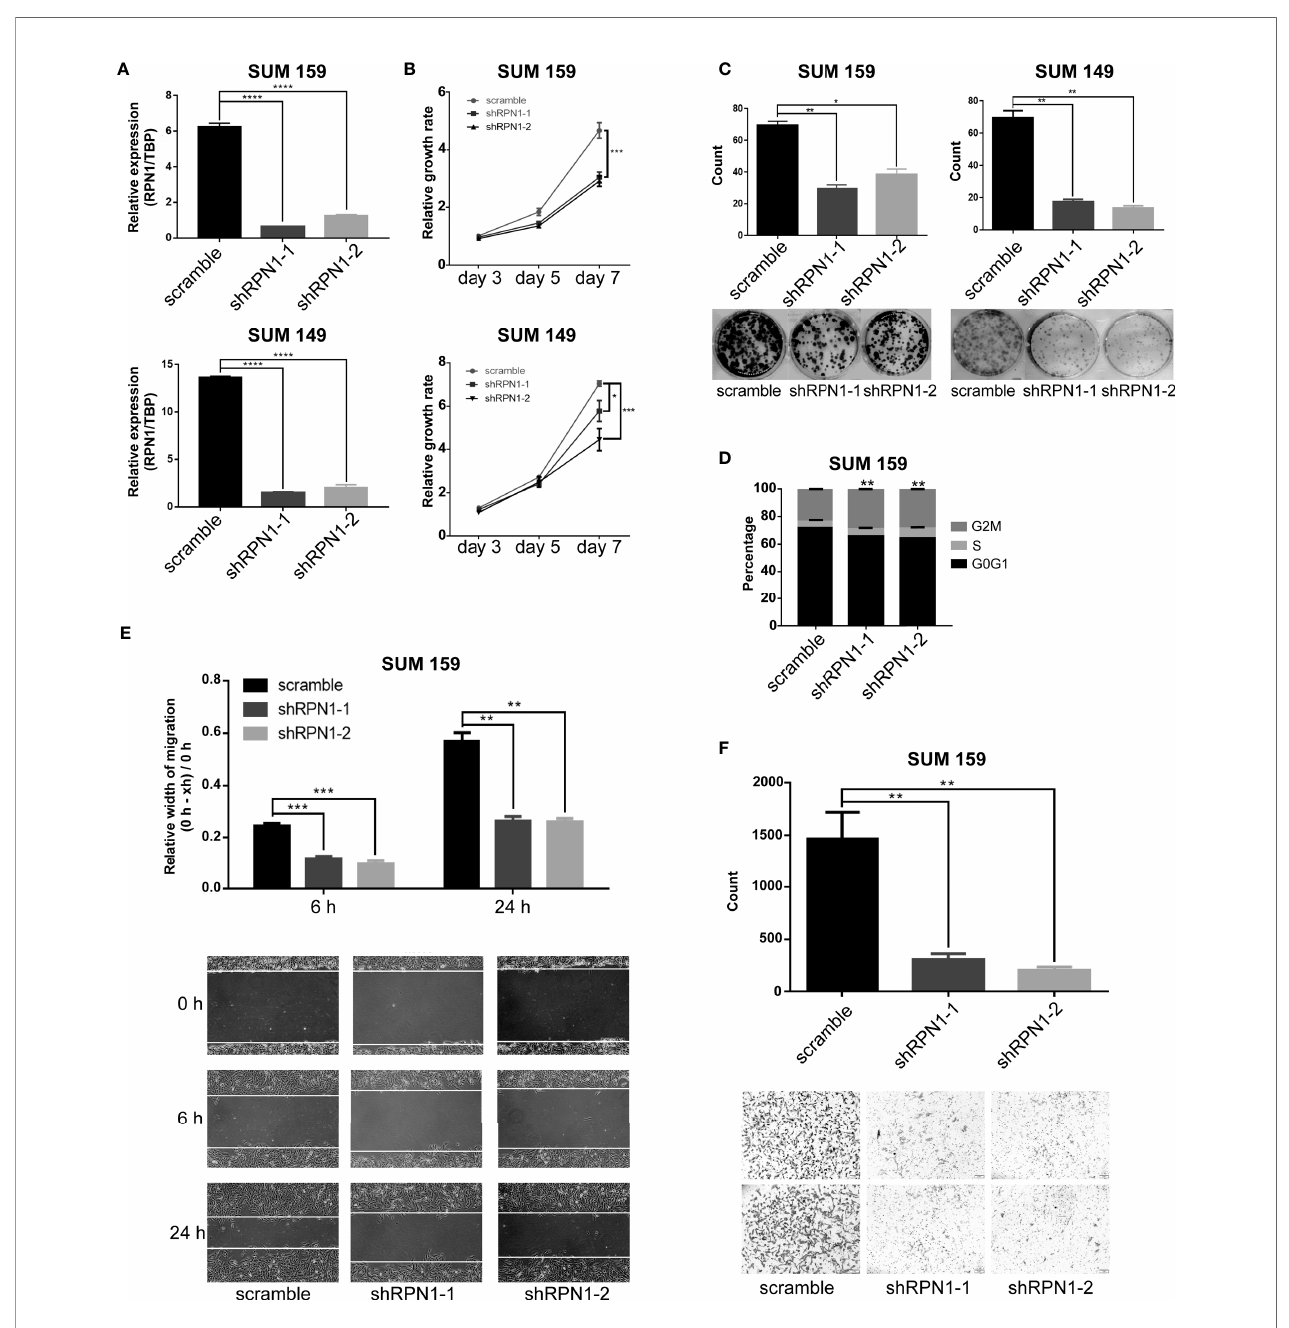
FIGURE 7 | RPN1 knockdown inhibited the growth and invasion of BLBC cells. (A) RPN1 was knocked down (scramble was the control). The expression of RPN1 was detected by qRT-PCR in SUM159 and SUM149. (B, C) MTT assay and Colony formation assay were used to measure the cell proliferation ability. (D) Cell cycle distribution analyzed by fl ow cytometry in SUM159 cells. (E, F) Wound healing assay and transwell assay were used to measure the cell migration and invasion ability. *P < 0.05, **P < 0.01, ***P < 0.001 and ****P <